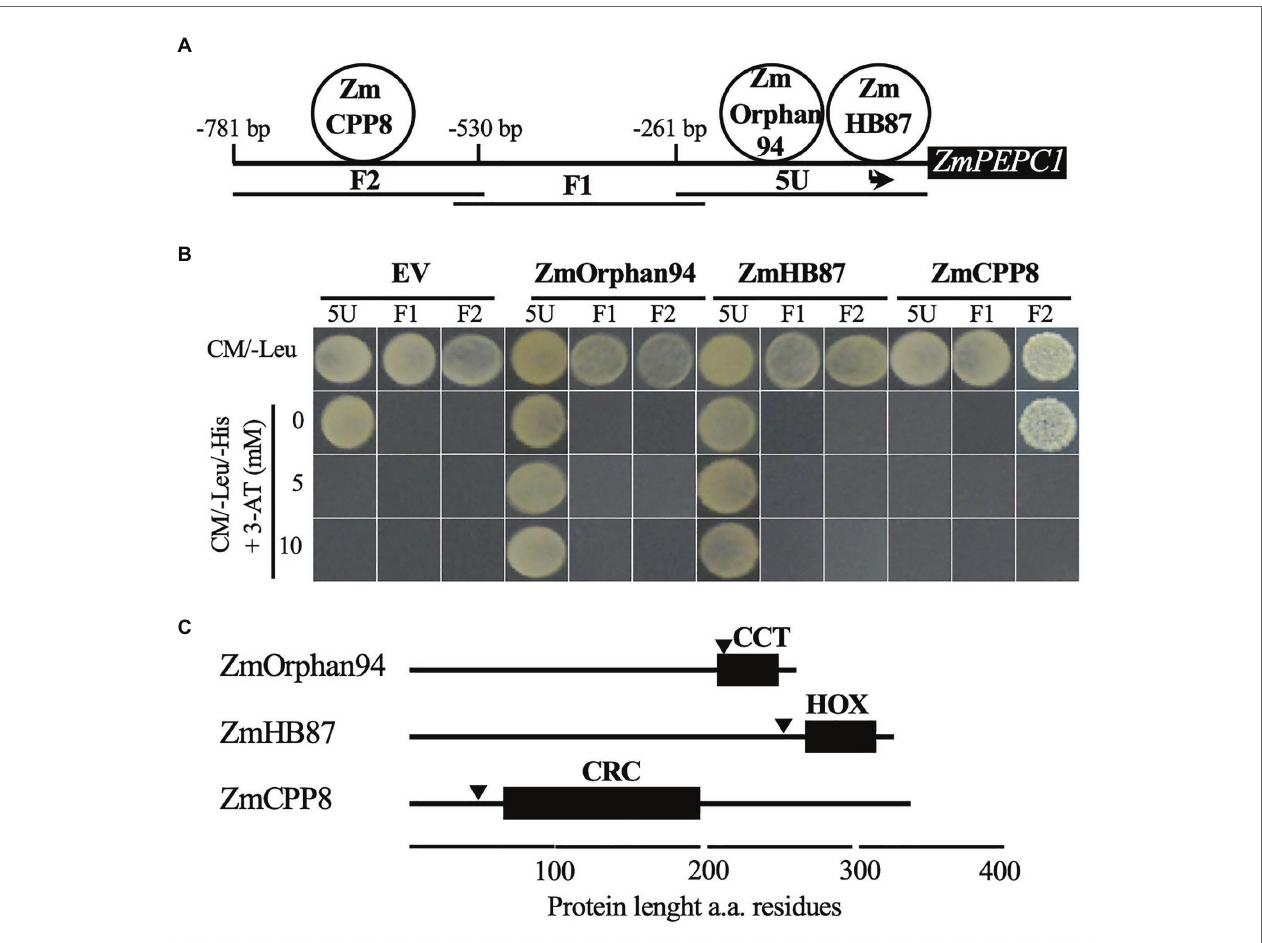
FIGURE 1 | Analysis of the transcription factors (TFs) binding to ZmPEPC1 upstream region. (A) Schematic representation of the three ZmPEPC1 upstream region fragments used in the yeast one-hybrid screenings. ZmHB87 and ZmOrphan94 were identified as binding to the 5 U fragment located between − 261 and 0 bp upstream of ZmPEPC1 ATG. The order of the TFs binding to 5 U fragment is representative but was not determined experimentally. ZmCPP8 was identified as binding to the F2 fragment located between − 530 and − 781 bp upstream of ZmPEPC1 ATG. (B) Validation of the interactions between identified TFs and ZmPEPC1 upstream region. Yeast bait strains carrying the different fragments of the ZmPEPC1 upstream region were transformed with plasmids to express ZmHB87, ZmOrphan94, and ZmCPP8, as well as with empty vector (EV). Growth of the transformed bait strains was analyzed on complete minimal (CM)/-Leu/-His medium (CM medium lacking Leucine and Histidine) supplemented with increasing concentrations of 3-amino-1,2,4-triazole (3-AT). (C) Schematic representation of ZmHB87, ZmOrphan94, and ZmCPP8 protein structures with homeodomain (HOX), CONSTANS, CO-like, and TOC1 (CCT), and C1-RNPXAFXPK-C2 (CRC) DNA-binding domains, respectively, determined by ScanProsite. Nuclear localization signals (arrowheads) were predicted by cNLS mapper. a.a. refers to amino